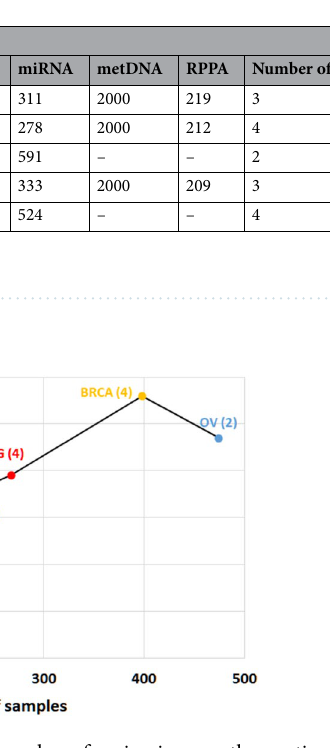
Figure 2. Effect of sample size and number of omic-views on the runtime of the proposed algorithm. Values in the parentheses indicate the number of